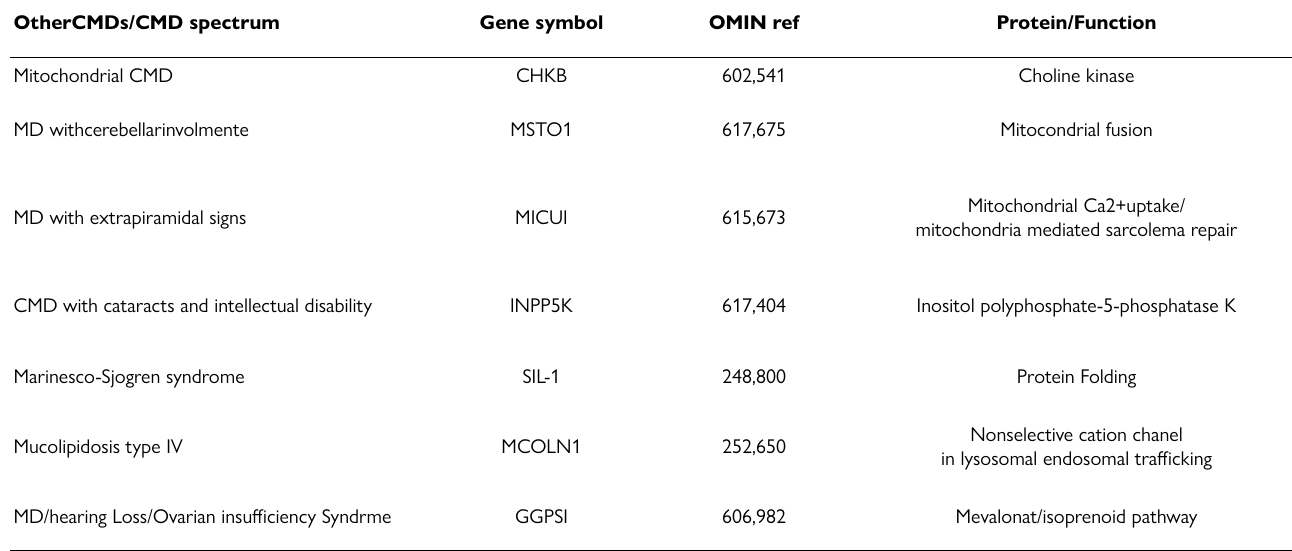
Table 1. Genes and Protein implicated in CMDs called CMD